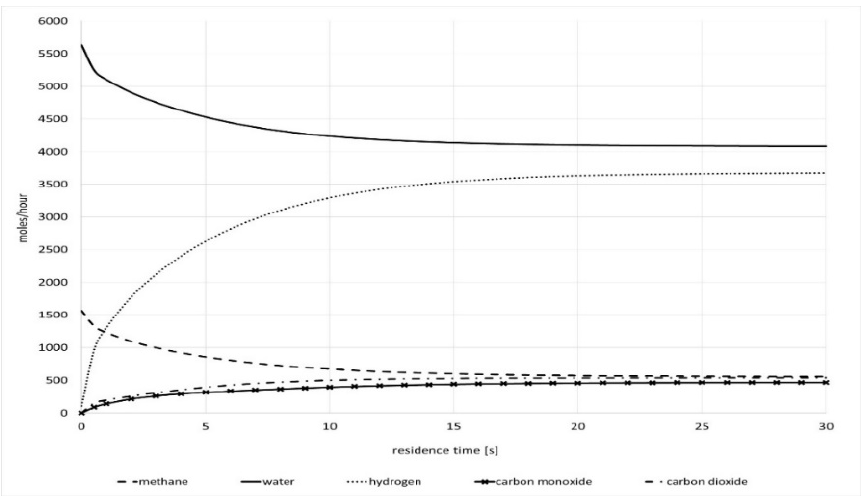
Figure 6. Dependence of the component molar flow as a function of residence time inside the reformer tubes according to the real process conditions given in Table 3.